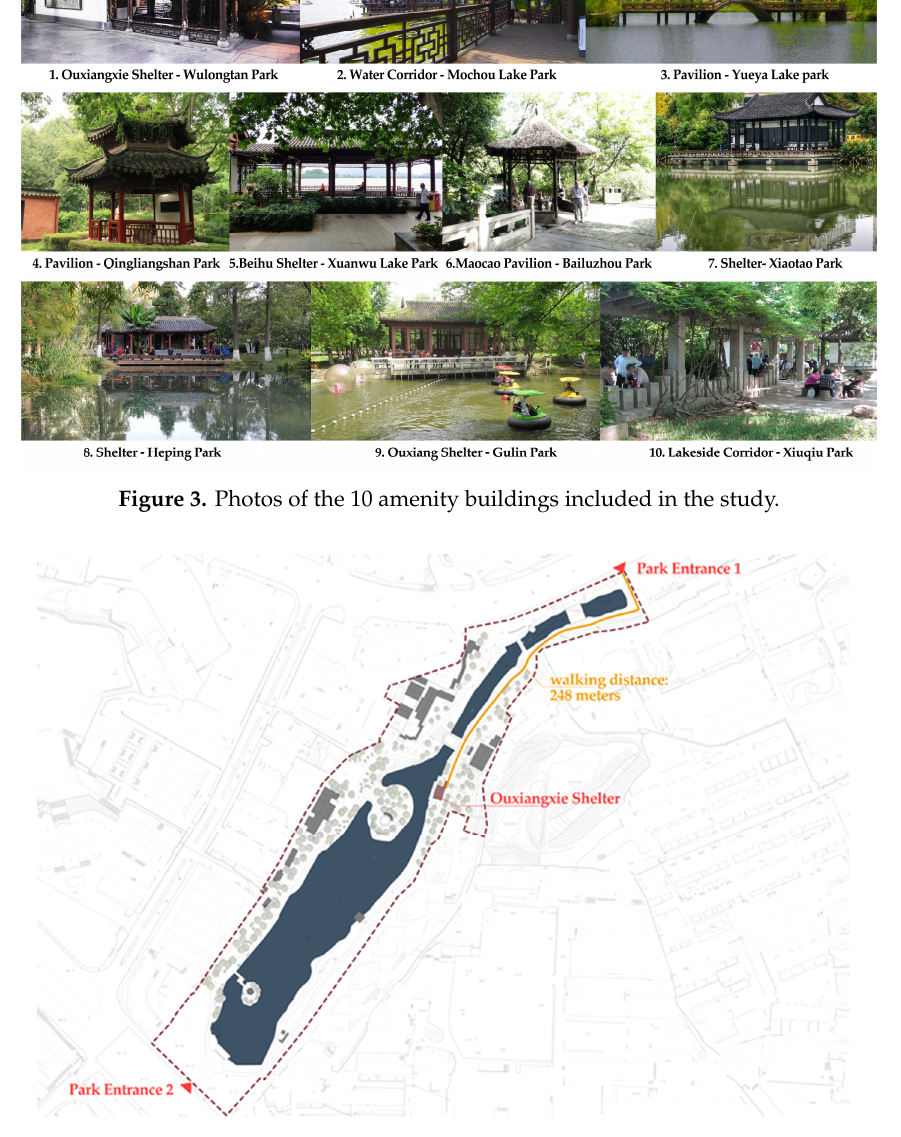
Figure 4. Example: Location of Ouxiangxie Shelter in Wulongtan Park .